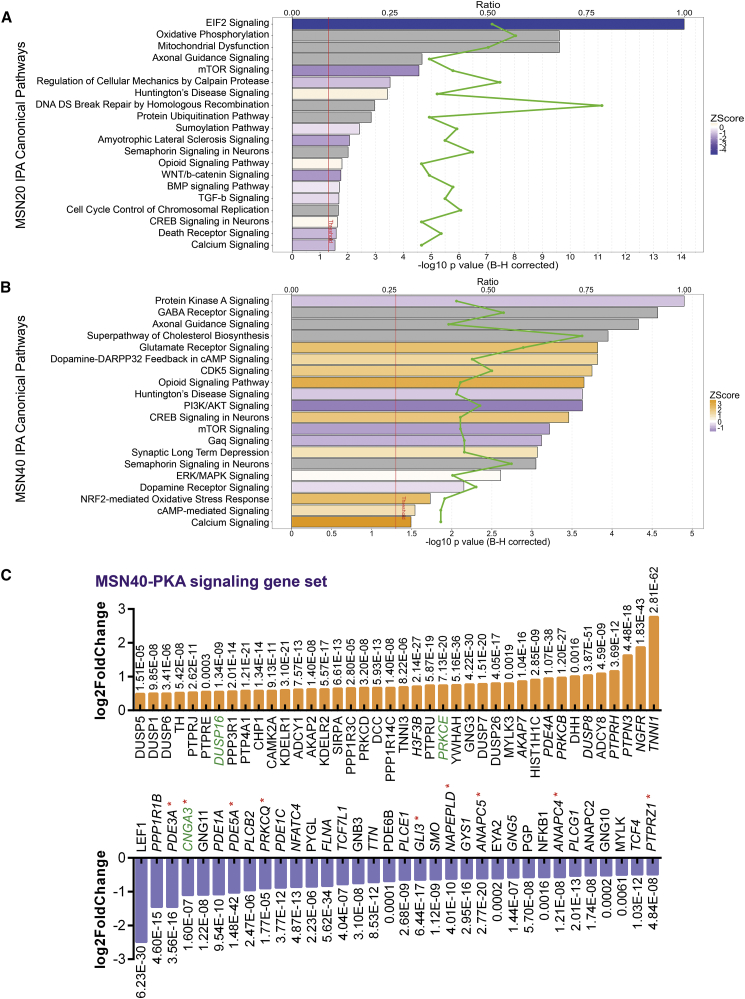
RNA-Seq Analysis Highlights a Role for CTIP2 in PKA-Regulated Protein Phosphorylation in hESC-Derived MSNs(A and B) Ingenuity pathway analysis (IPA) of MSN20 (A) and MSN40 (B) CTIP2KO DEGs shows significant enrichment of genes regulating mitochondrial function at 20 DIV, PKA and CDK5 signaling as well as dopamine-DARPP32 feedback in cAMP signaling at 40 DIV (full gene set lists for both time points are presented in Table S2).(C) Differential expression statistics for MSN40 DEGs within the PKA gene set at fold change threshold of |1.4|, with direct CTIP2 targets highlighted in green. Genes analyzed by RT-PCR in independent control and CTIP2KO MSN samples are indicated in italic, with red asterisks marking validated differential expression.See also Figure S3 and Tables S2 and S3.